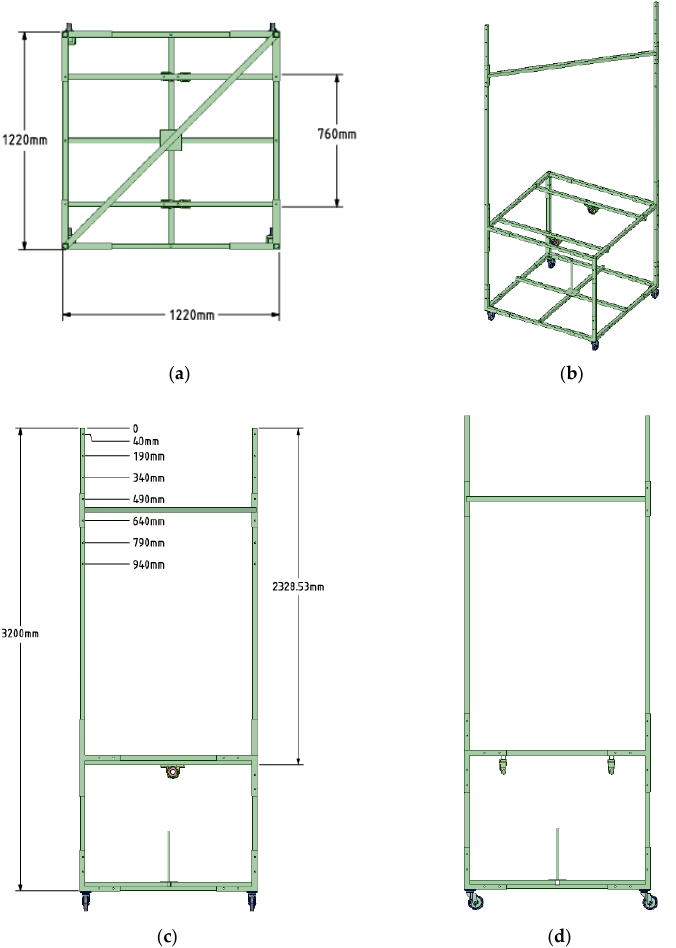
Figure 1. CAD model of the multiuse indoor test platform for multirotor testing: ( a ) Top view; ( b ) isometric view; ( c ) front view; ( d ) side view.